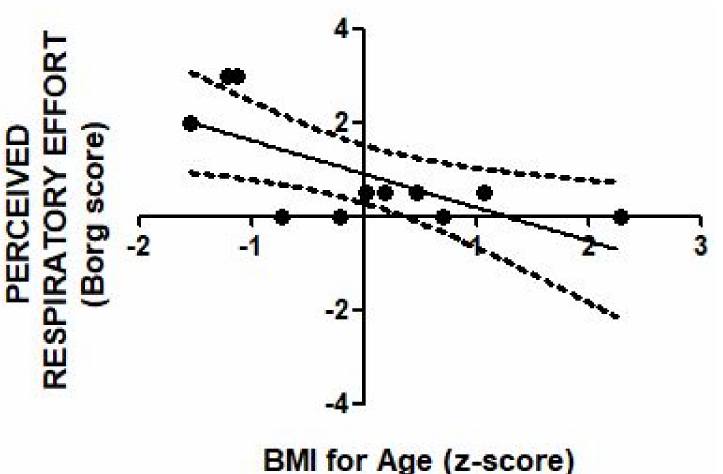
Figure 2. Scatter diagram of individual values of BMI-for-age z-score and the Borg rating of perceived respiratory effort in adolescent scoliosis with the Sforzesco brace. The solid line depicts regression function of y on x; the inverse correlation is significant (r = − 0.68; p = 0.021). Dashed curves depict 95% confidence